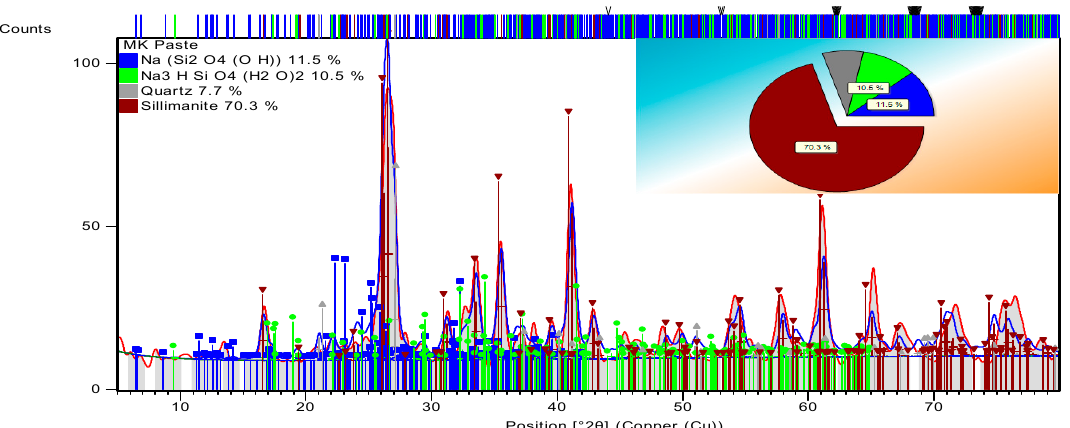
Figure 17. XRD of Metakaolin paste at 7 days of ambient curing.